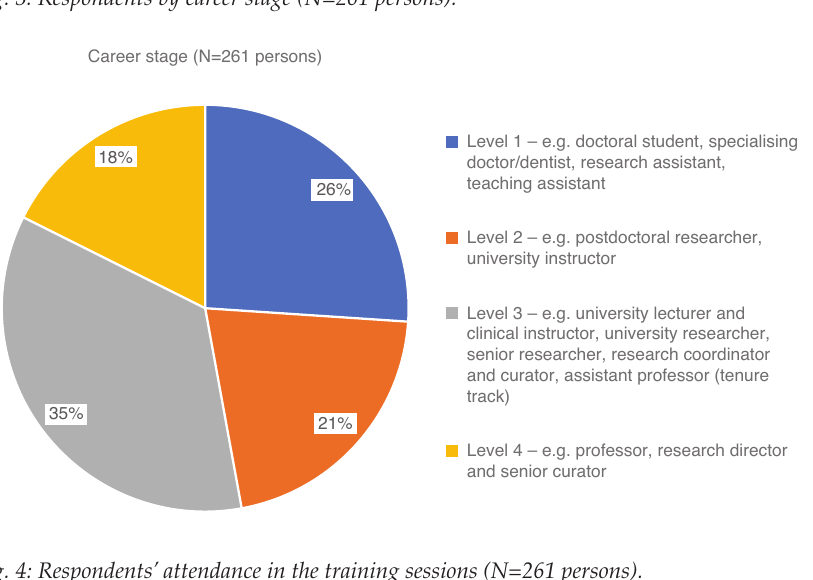
Fig. 4: Respondents’ attendance in the training sessions (N=261